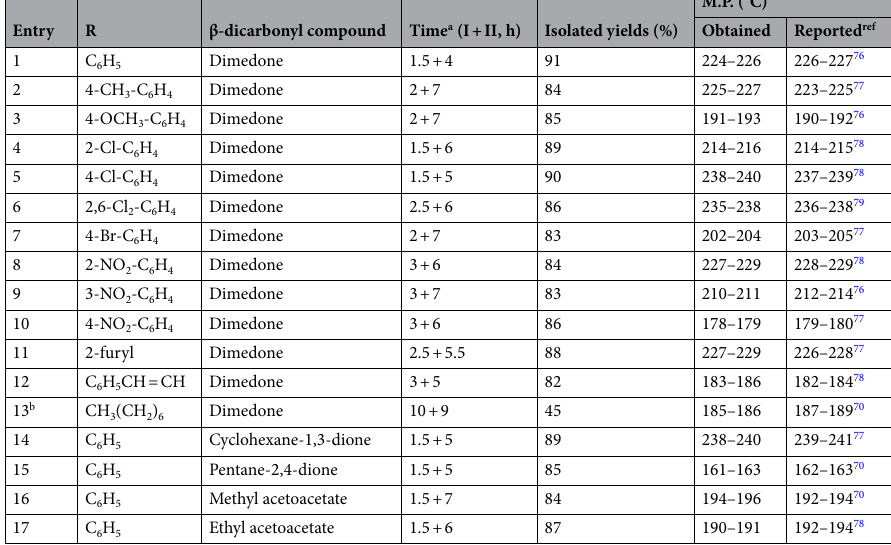
Table 4. Synthesis of chrome-derivatives via multicomponent TOP catalyzed by (γ-Fe 2 O 3 -Im-Py) 2 WO 4 . a Reaction conditions: (I) benzyl alcohol (1 mmol), TBHP (6 mmol), (γ-Fe based on W content and relative to alcohol), and (II) malononitrile (1.2 mmol) and β-dicarbonyl compounds (1.2 mmol). b (γ-Fe